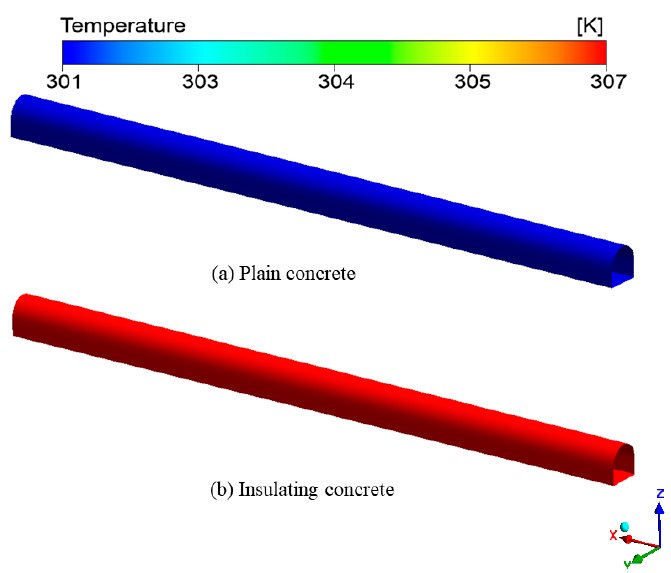
Figure 18. Temperature distribution of the wall surface of the surrounding rock: ( a ) Temperature distribution on the wall surface of the surrounding rock in the roadway under plain concrete support; ( b ) Temperature distribution on the wall surface of the surrounding rock in the roadway under insulated concrete support.